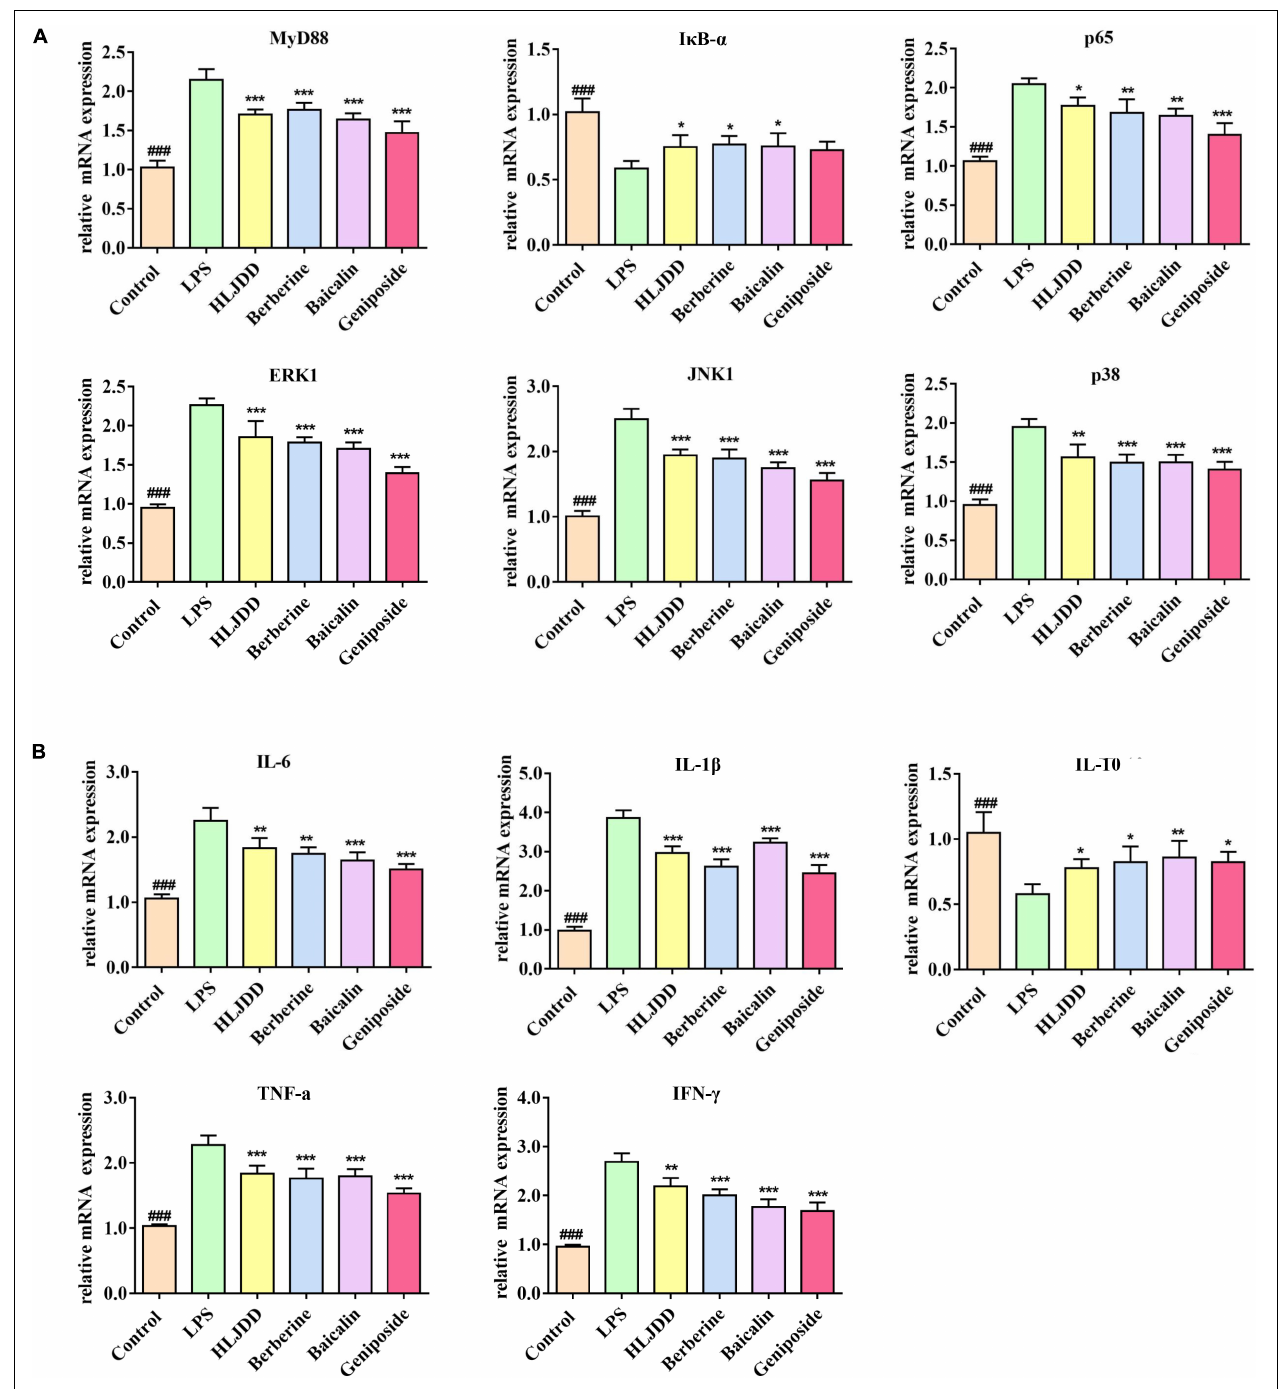
FIGURE 2 | Huanglian Jiedu decoction (HLJDD) and its three major components alleviated the mRNA expression of the key mediators and inflammatory cytokines. (A) HLJDD and its three major components could inhibit lipopolysaccharide (LPS)-induced inflammation by ameliorating the mRNA expression of MyD88, p65, I κ B- α , ERK, JNK, and p38 controlled by the TLR4/MyD88 pathway. (B) HLJDD and its three major components ameliorated IL-6, IL-1 β , TNF- α , IL-10, and IFN- γ to return to normal level. ∗ P < 0.05, ∗∗ P < 0.01, and ∗∗∗ P < 0.001, four drug treatment groups compared to the LPS group. ### P < 0.001, LPS group compared to the control group. MyD88: Binding Toll-like Receptor. p65: Response to cytokine. I κ B- α : Negative regulation of NF- κ B transcription factor activity. ERK, JNK, p38: Activation of MAPK activity. IL-6, IL-1 β , TNF- α , IL-10, IFN- γ : Regulation of inflammatory response.